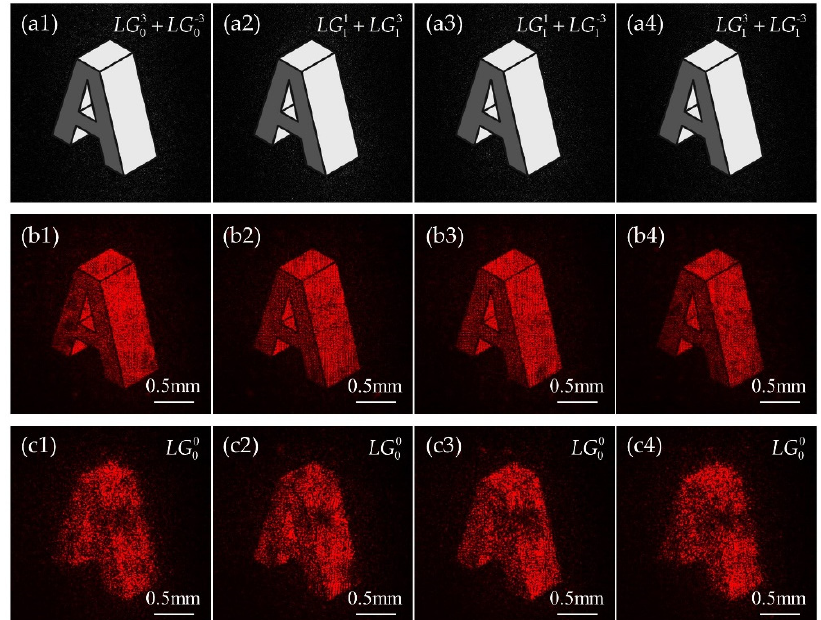
Figure 6. ( a ) Simulated results for correct illumination with ( a1 ) ( p 1 , l 1 ) = (0, 3) and ( p 2 , l 2 ) = (0, − 3), ( a2 ) ( p 1 , l 1 ) = (1, 1) and ( p 2 , l 2 ) = (1, 3), ( a3 ) ( p 1 , l 1 ) = (1, 1) and ( p 2 , l 2 ) = (1, − 3), ( a4 ) ( p 1 , l 1 ) = (1, 3) and ( p 2 , l 2 ) = (1, − 3). ( b ) Experimental results for the composite OAM beam with ( b1 ) ( p 1 , l 1 ) = (0, 3) and ( p 2 , l 2 ) = (0, − 3), ( b2 ) ( p 1 , l 1 ) = (1, 1) and ( p 2 , l 2 ) = (1, 3), ( b3 ) ( p 1 , l 1 ) = (1, 1) and ( p 2 , l 2 ) = (1, − 3), ( b4 ) ( p 1 , l 1 ) = (1, 3) and ( p 2 , l 2 ) = (1, − 3). ( c1 – c4 ) Experimental results with wrong Gaussian beam illumination of ( p , l ) = (0, 0).